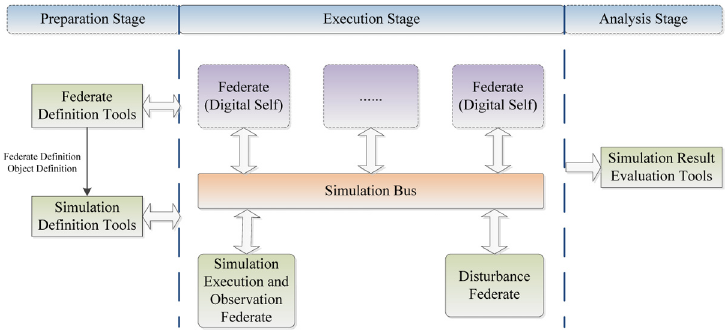
Figure 2. Crowd network simulation development